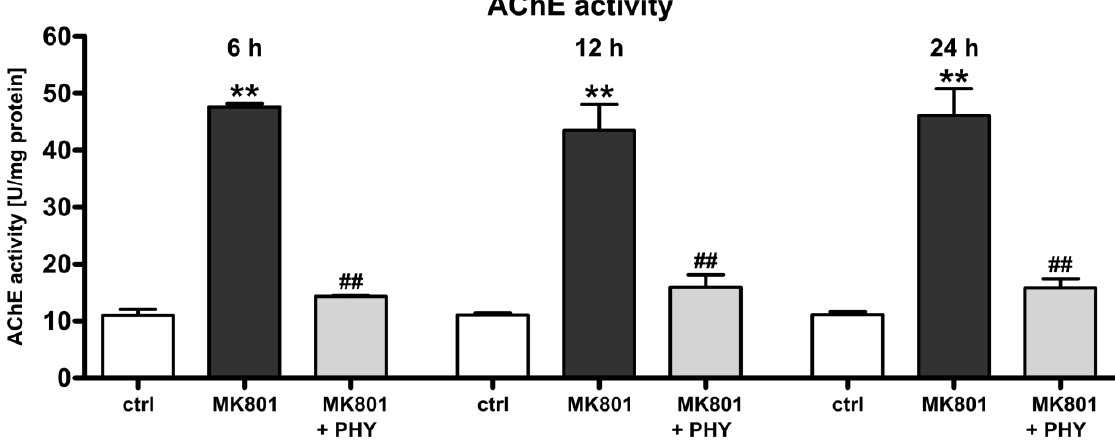
Figure 1. Normalization of acetylcholinesterase (AChE) activity in MK801 (dizocilpine) treated rat pups after physostigmine treatment. AChE activity, determined by an enzymatic activity assay revealed a significant increase in AChE activity at 6, 12 and 24 h after MK801 treatment (dark grey bars) whereas a single co-application of physostigmine significantly reduced AChE activity (light grey bars). Bars represent mean + SD, n = 6 per group, ** p < 0.01 compared to vehicle treated pups, ## p < 0.01 compared to MK801 treated pups, respectively. ctrl: control; PHY: physostigmine.